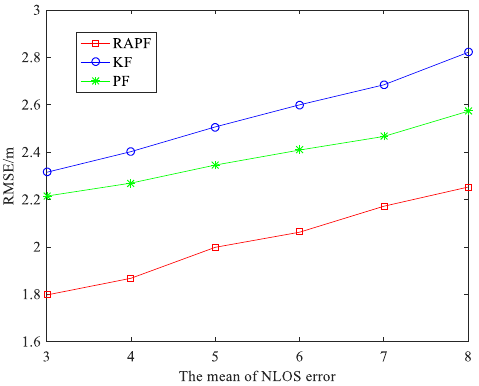
Figure 9. The RMSE versus the mean of NLOS error.